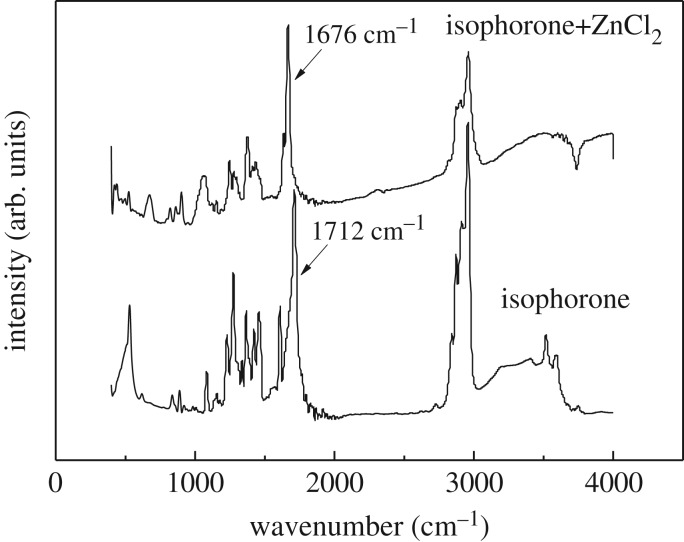
The infrared spectra of isophorone with and without ZnCl2.